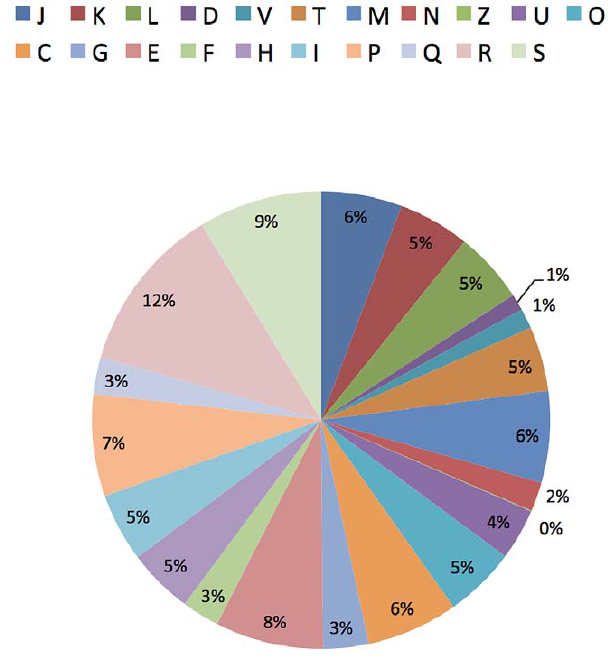
Figure 2. Pie chart showing the distribution of identified proteins (combined from all three growth conditions) in COG categories. J Translation; K Transcription; L Replication, recombination and repair; D Cell cycle control; T Signal transduction mechanism; M Cell wall/membrane biogenesis; N Cell motility; Z Cytoskeleton; U Intracel- lular trafficking and secretion; O Posttranslational modification, protein turnover, chaperones; C Energy production and conversion; G Carbohydrate transport and metabolism; E Carbohydrate transport and metabolism; F Nucleotide transport and metabolism; H Coenzyme transport and metabolism; I Lipid transport and metabolism; Q Secondary metabolites biosynthesis, transport and catabolism; R General function prediction only; S Function unknown. The COG categories were unknown for plasmid encoded proteins and 518 chromosomal proteins.